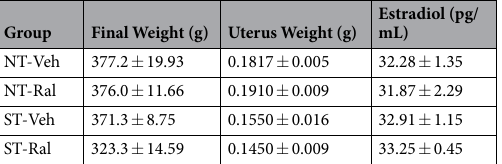
Table 1. Final body weight, uterine weight/100 g of body weight and estradiol plasma concentration (n = 10) of aged female Wistar rats (21 month) that performed or not strength training, treated for 16 weeks with Veh or Ral (n = 10). Statistical analysis was performed with two-way ANOVA, followed by Tukey post-hoc testing (p < 0.05) to analyze the effect of strength training (ST) and raloxifene (Ral) treatment, and any interactions (ST * Ral). Abbreviations: Veh = vehicle, Ral = raloxifene, NT-Veh = non-trained and treated with vehicle; NT-Ral = non-trained and treated with raloxifene; ST-Veh = strength training and treated with vehicle; ST- Ral = strength training and treated with